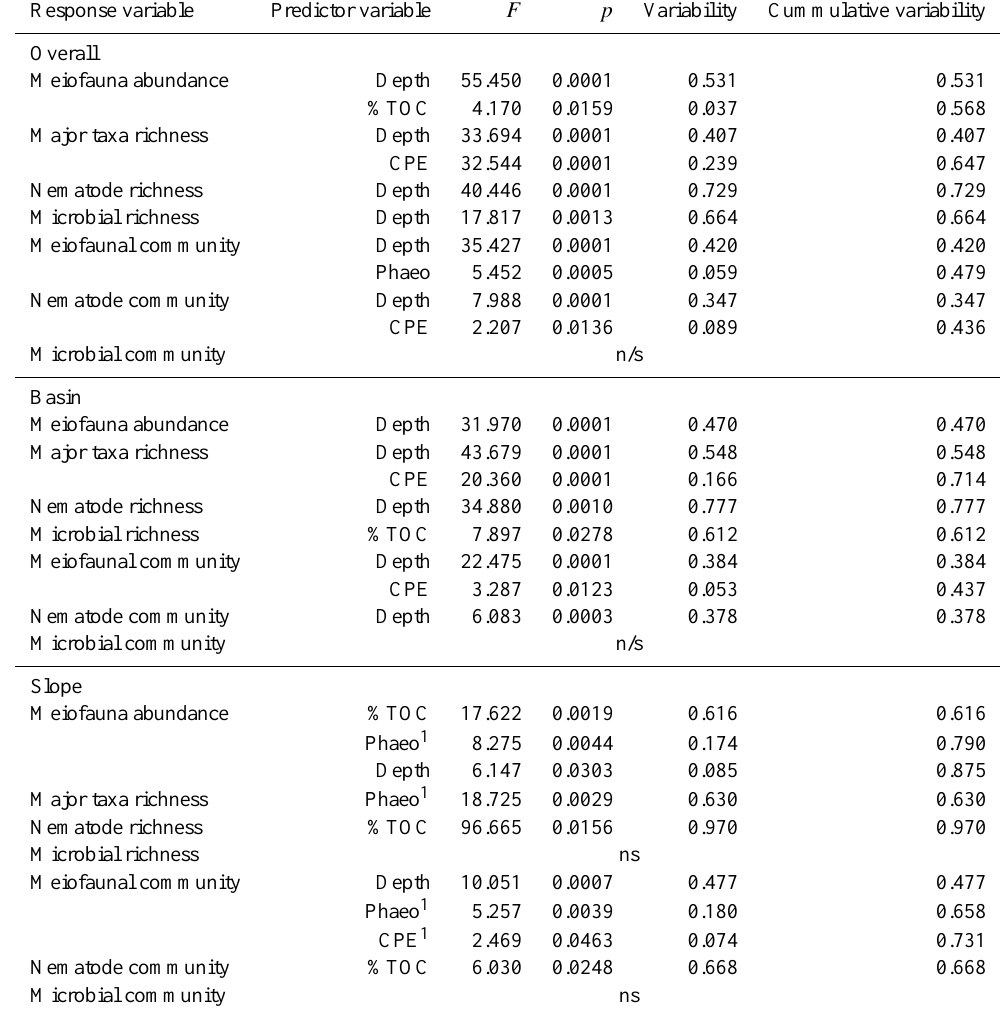
Table 6. Results of multiple stepwise DISTLM analysis, a permutational regression routine, for exploring relationships of meiofauna and microbes with environmental (predictor) variables. p values were obtained using 9999 permutations of residuals under a reduced model. For each response variable only the best model (based on Adjusted R 2 ) with the variables that significantly contribute to explain the variance are provided. TOC: total organic carbon; CPE: chlorophyll pigment equivalent; ns: statistically not significant ( p >